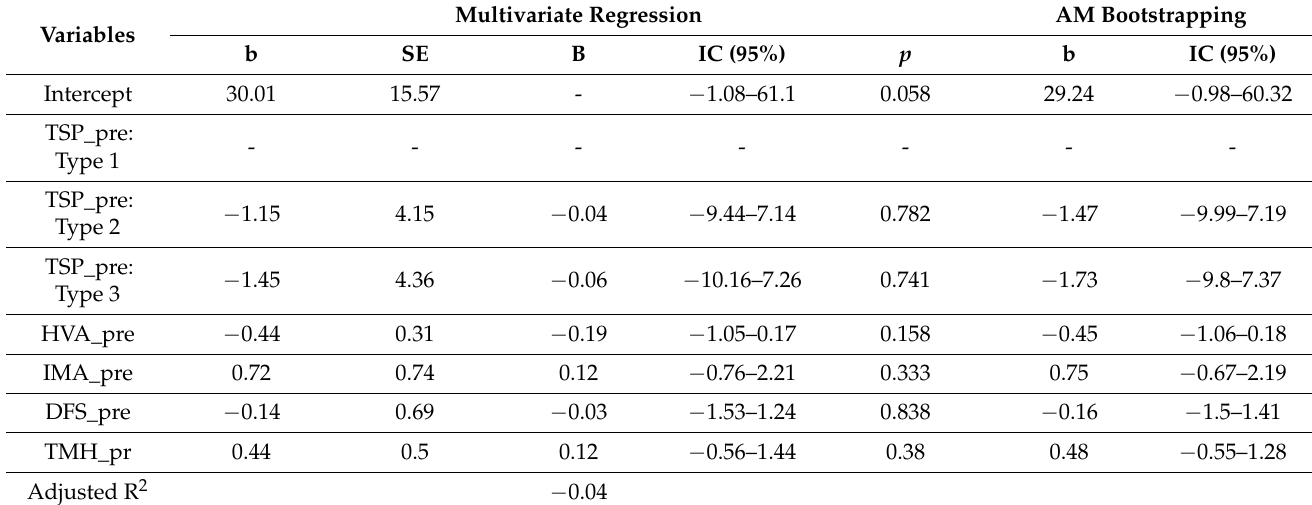
Table 3. Multivariate regression of preoperative AOFAS values with the preoperative radiological measures. Pre: Preoperative values. DFS: Distance of the fibular sesamoid bone to the second metatarsal axis. TMH: Translation of the first distal metatarsal head. HVA: Hallux valgus angle. IMA: I–II intermetatarsal angle. TSP : Tibial Sesamoid Position. AOFAS: American Orthopaedic Foot and Ankle Society Questionnaire.